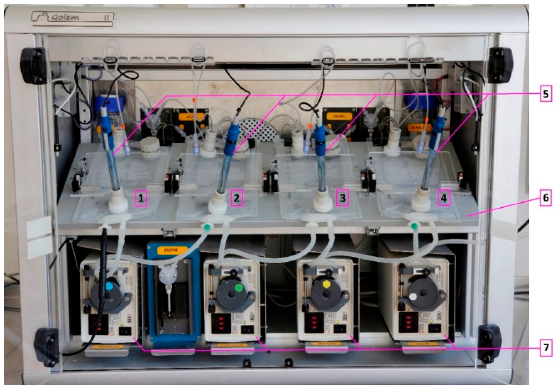
Figure 1. Golem v2 apparatus photographed from the front view: (1) stomach, (2) duodenum, (3) jejunum, (4) ileum, (5) pH probes, (6) heating platform, and (7) peristaltic pumps.